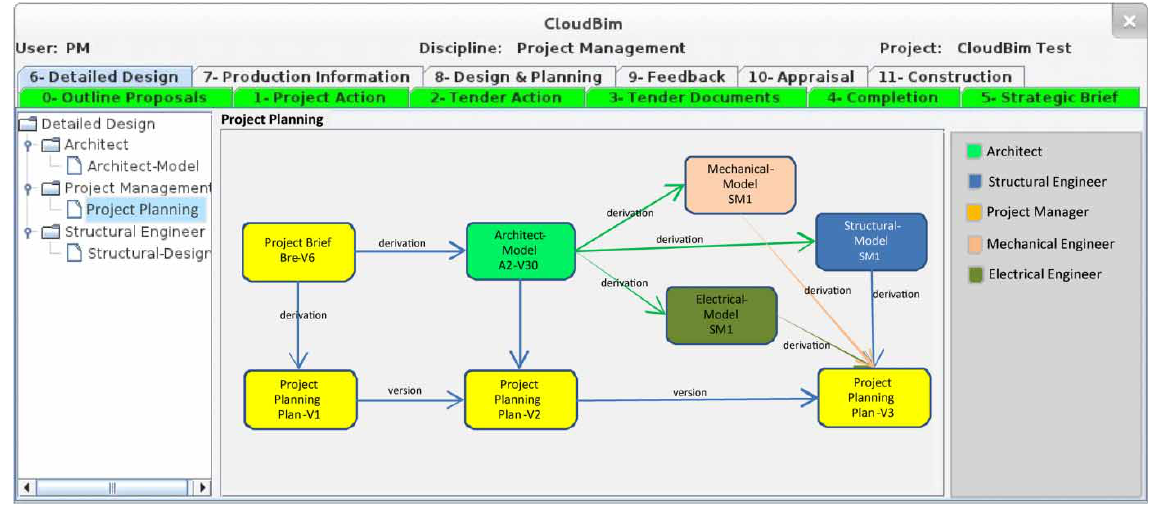
Fig. 13. Project management